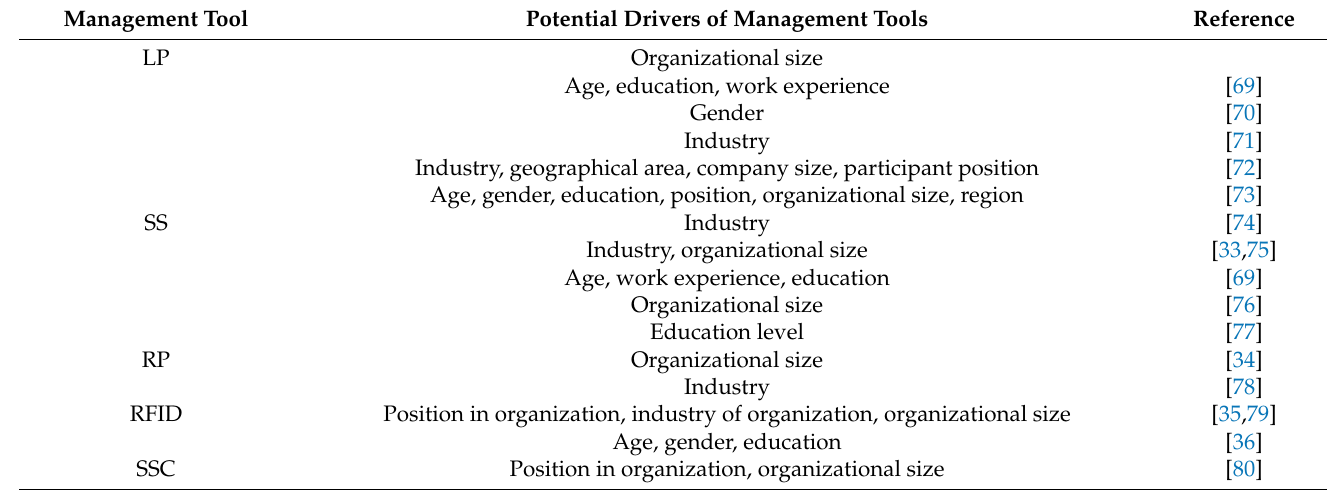
Table 1. Potential drivers of management tool usage a